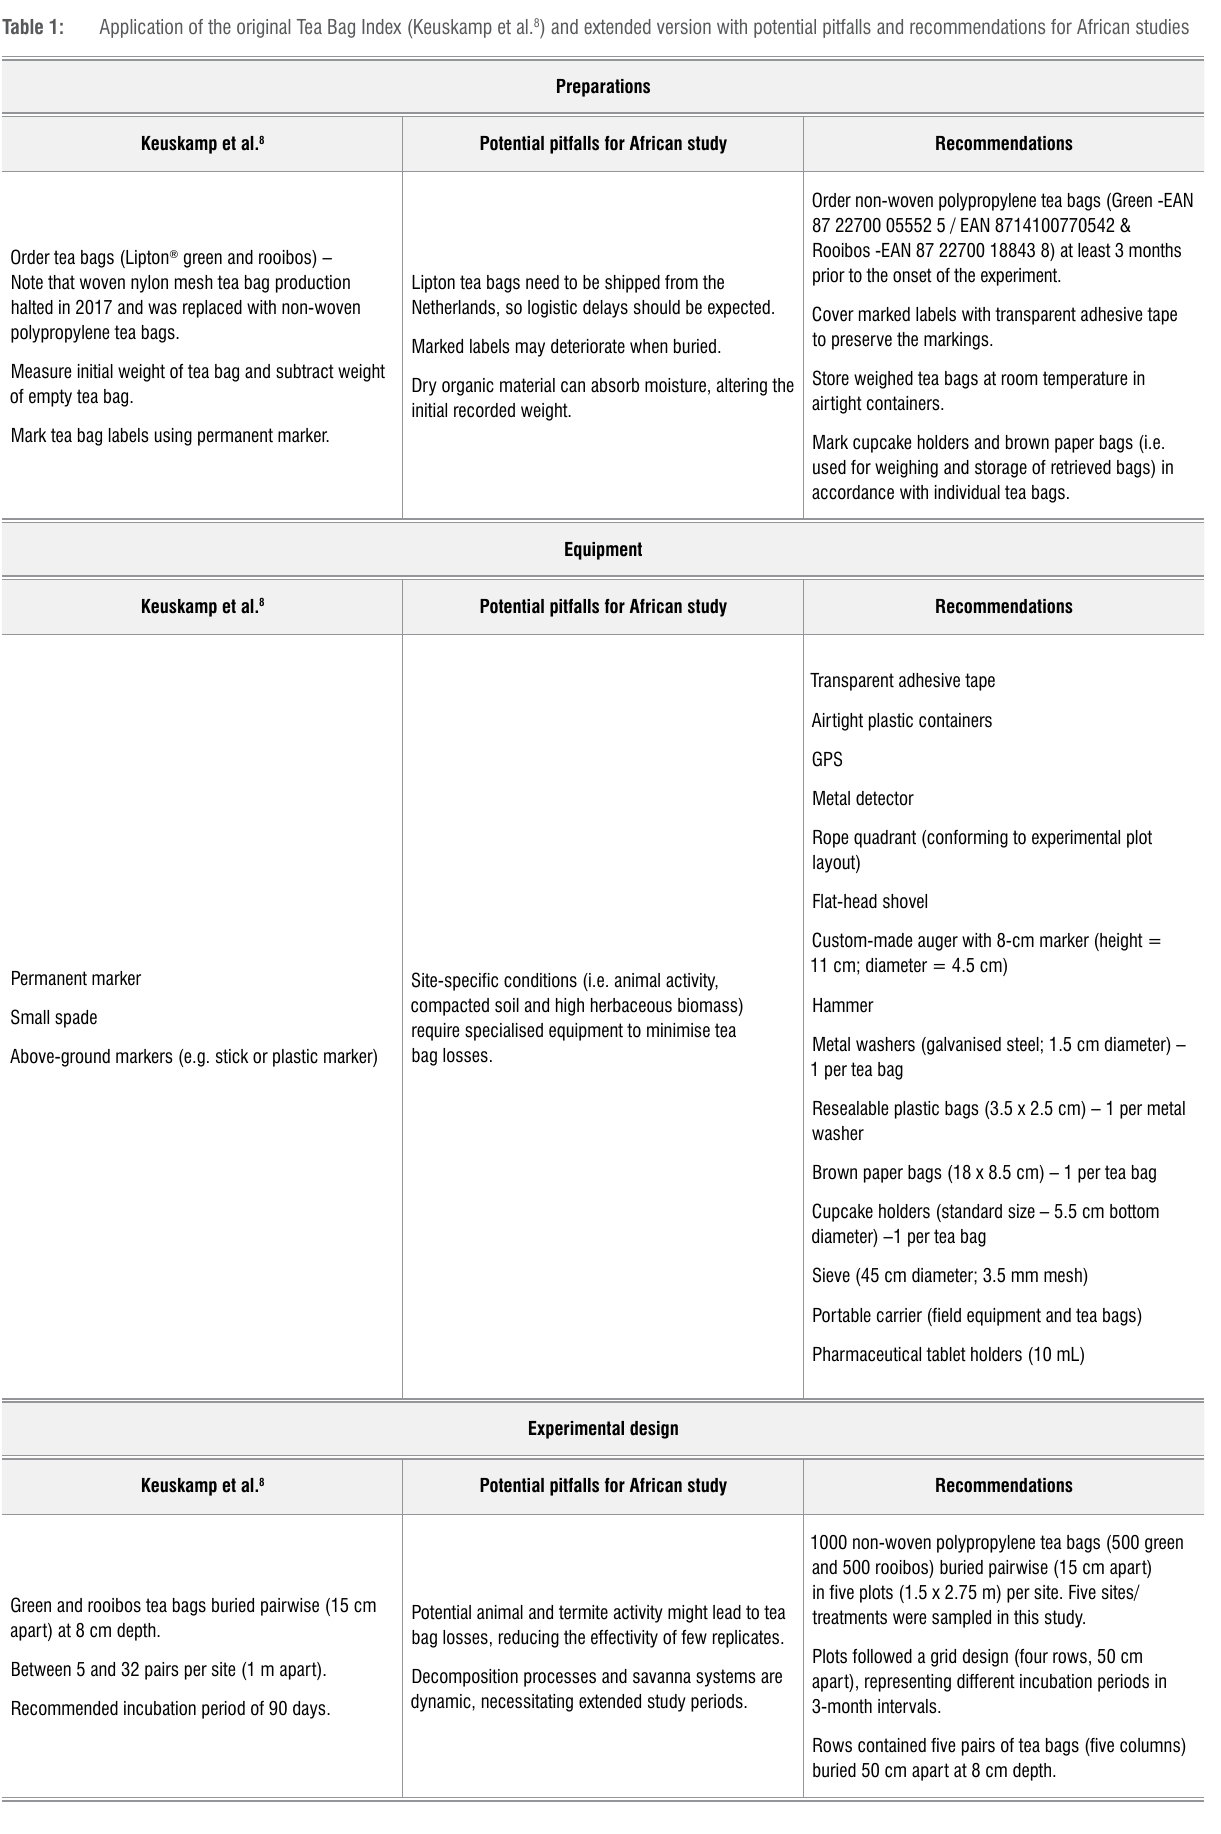
Green and rooibos tea bags buried pairwise (15 cm apart) at 8 cm depth. Between 5 and 32 pairs per site (1 m apart). Recommended incubation period of 90